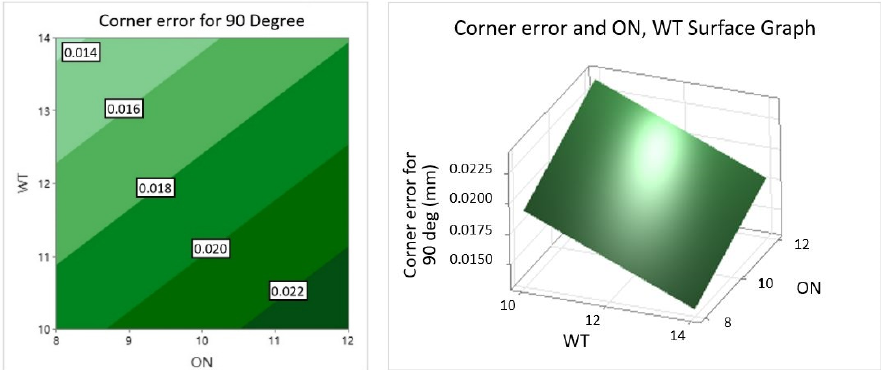
Figure 6. 2D contour and 3D surface plots corner error for 90° corner.